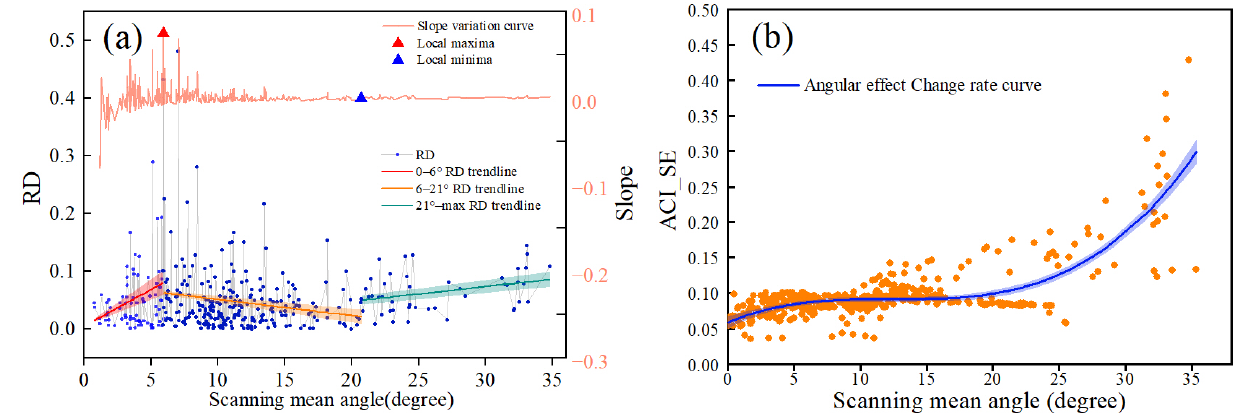
14 of 22 Figure 11. Statistics for the LiDAR-based vertical structure variables: density metrics ( a ) and height LiDAR metric ( b ). The Δ Hn values are the vegetation heights, representing the value at each height